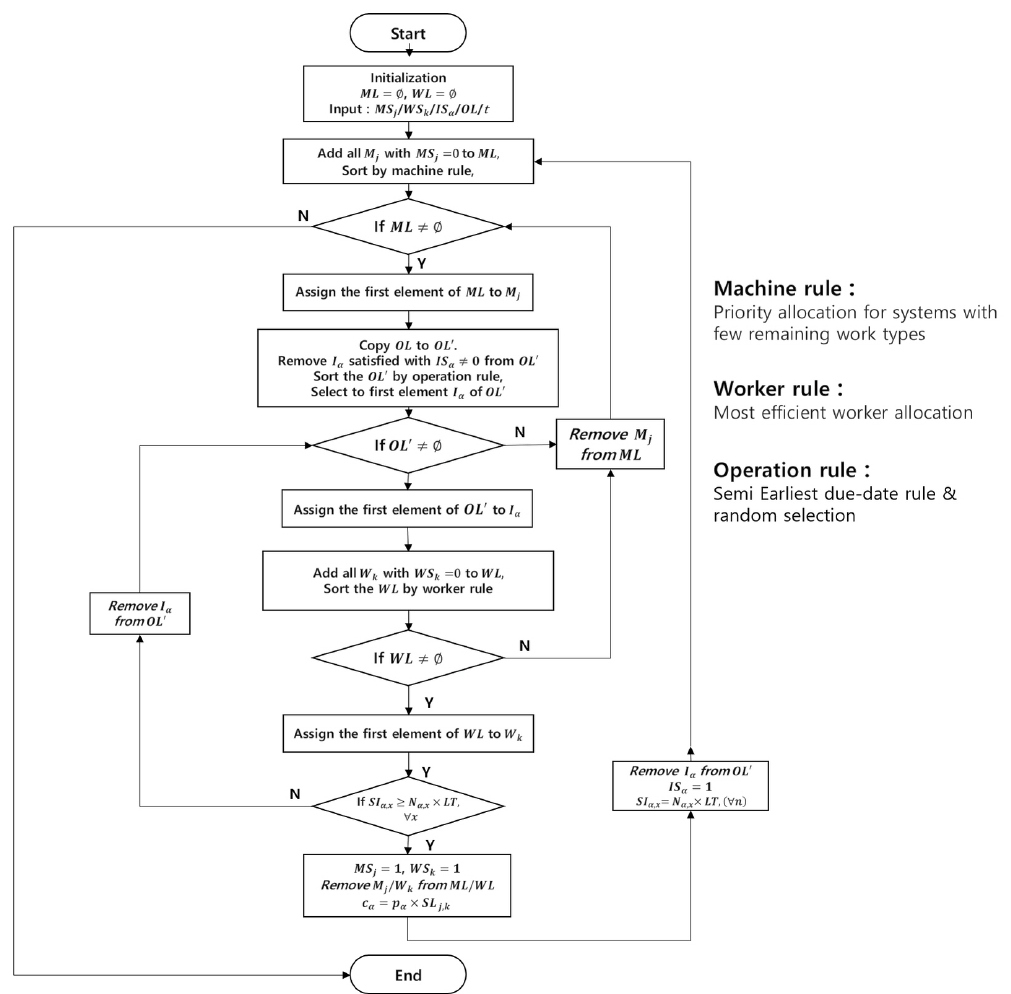
Figure A1. Initial allocation